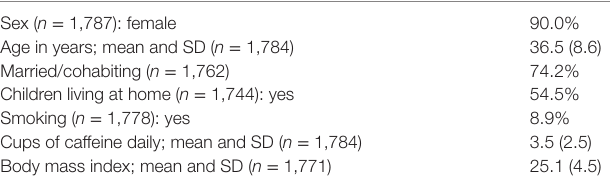
TaBle 1 | Demographic characteristics of Norwegian nurses included in the study.